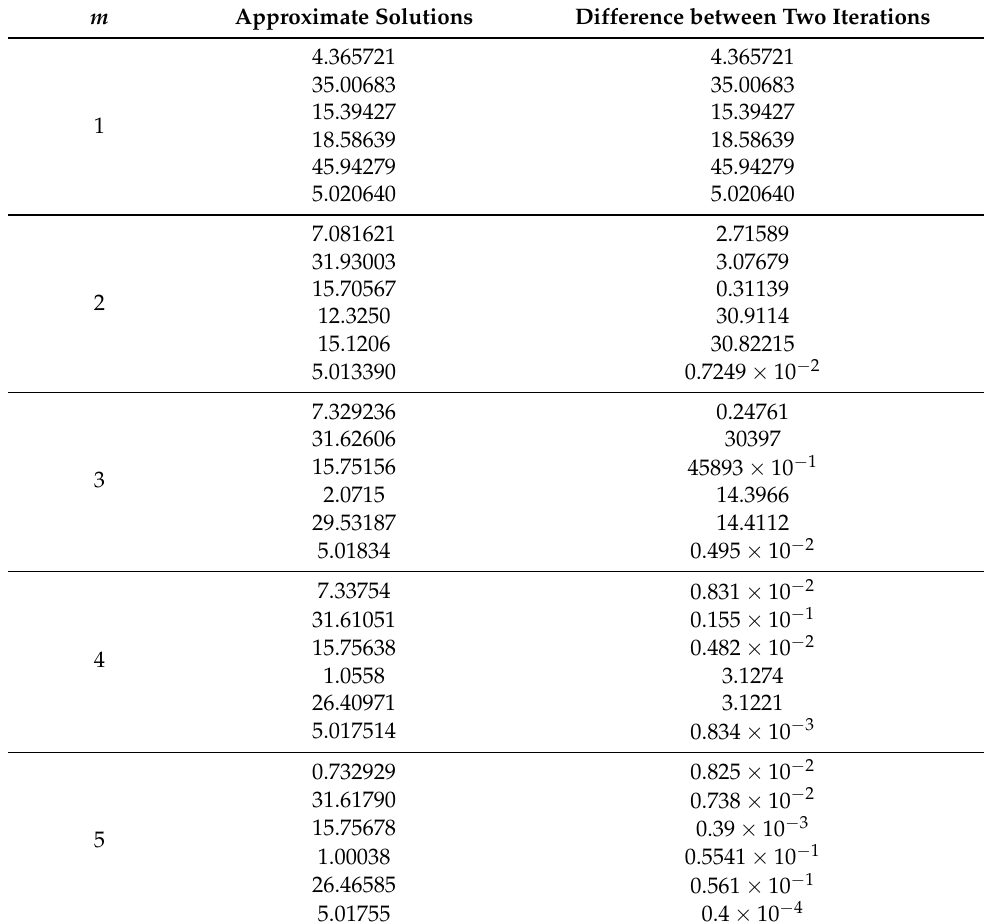
Table 3. Numerical results based on the FPA and Condition (1) for t = 0.2, ρ = 1, ¯ h = − 0.8 and ε = 10 − 4 .